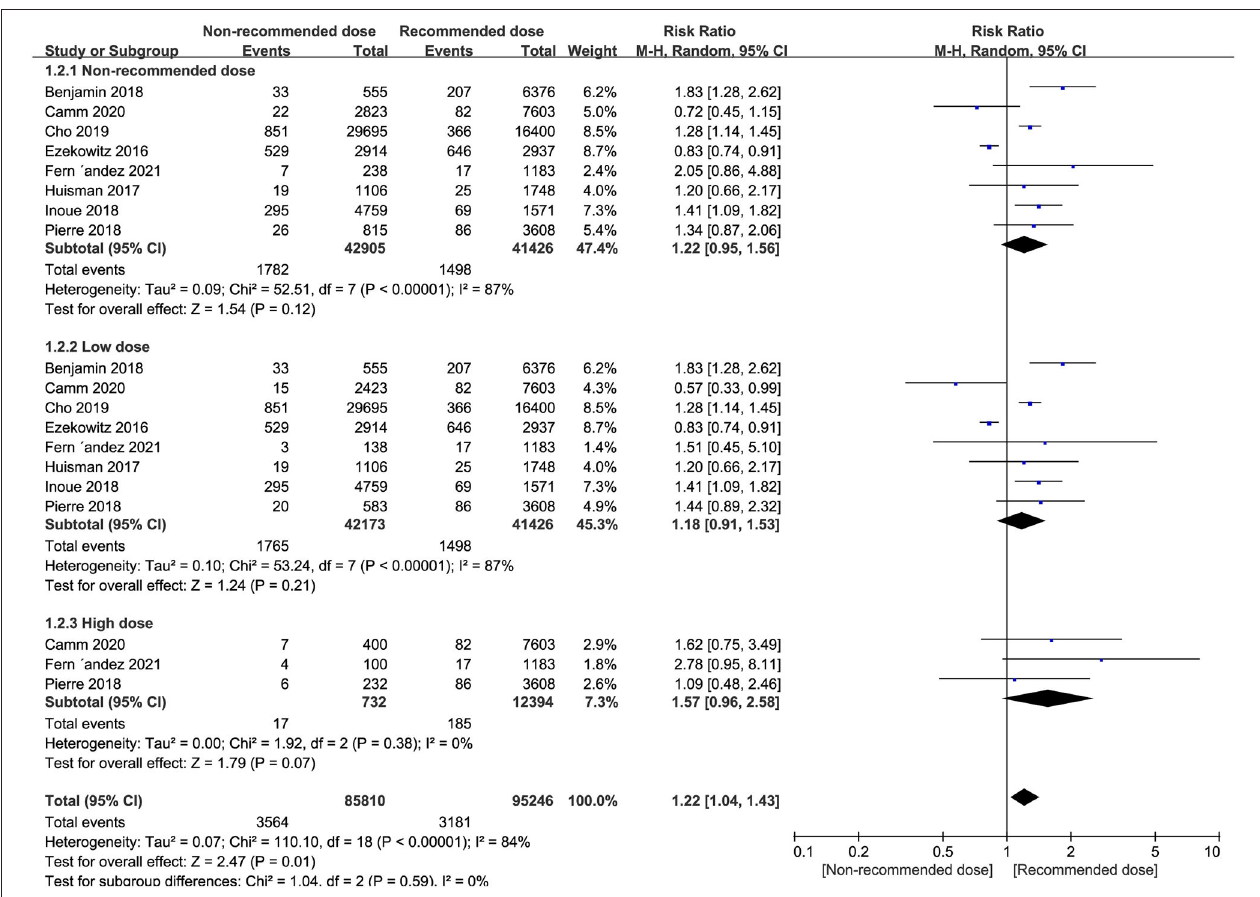
FIGURE 3 | Forest plot for major or clinically relevant bleeding in non-recommended dose compared to recommended dose of NOACs. NOACs, new oral anticoagulants.